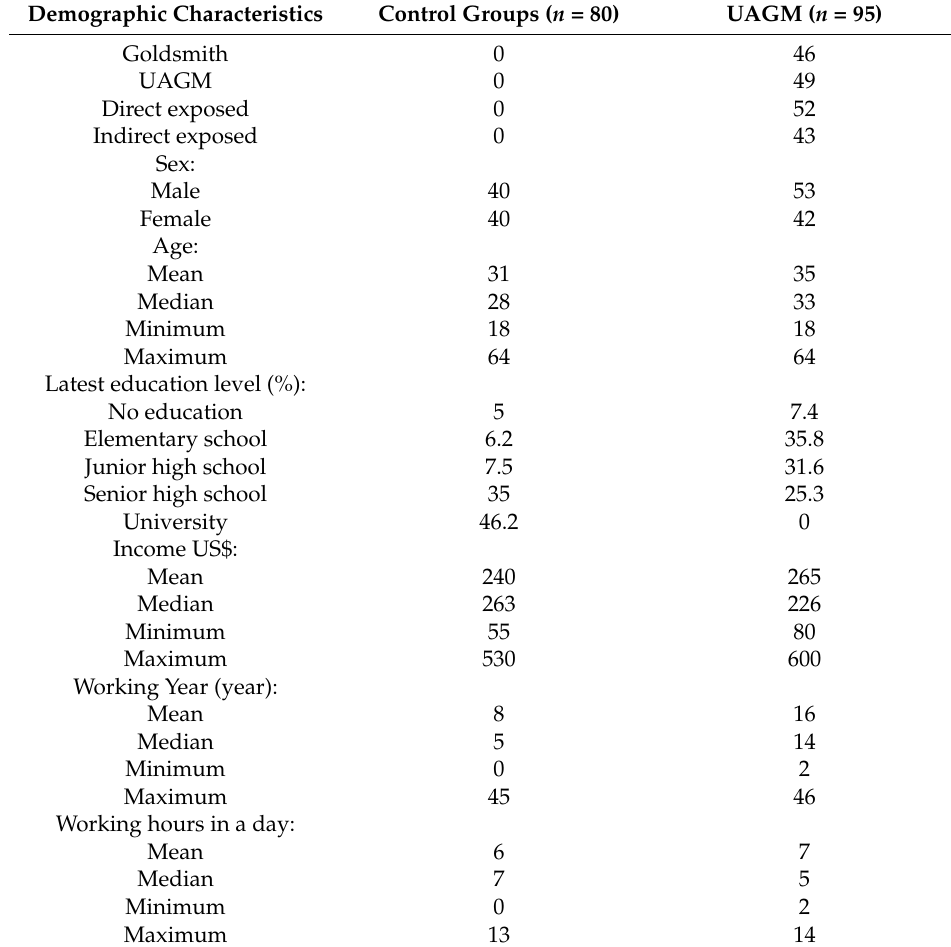
Table 1. Demographic characteristics of urban artisanal gold mining